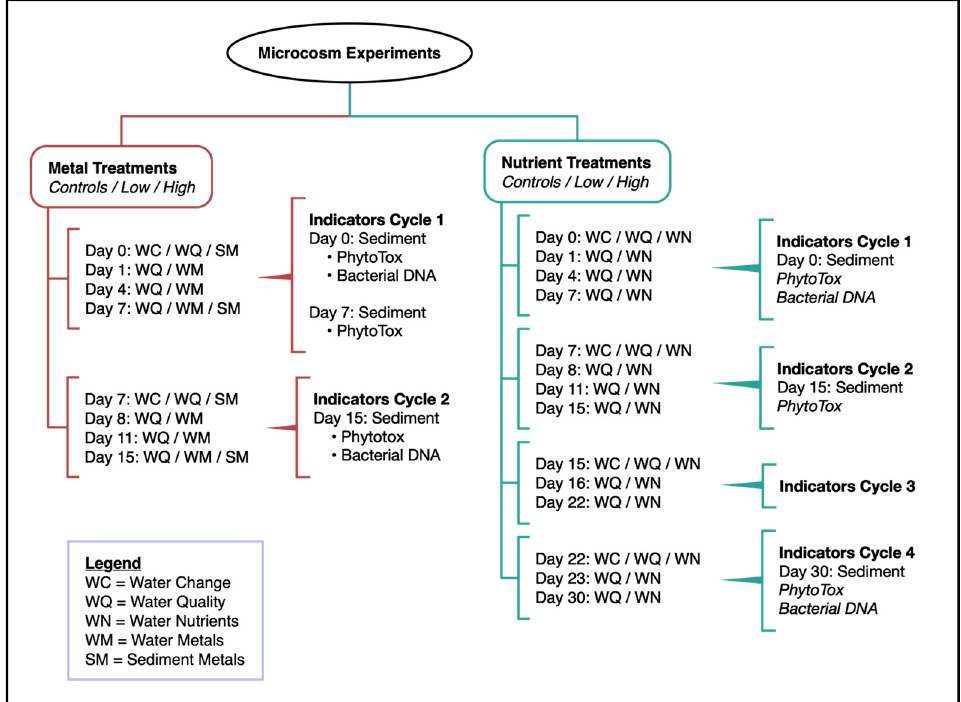
Figure 4. Experimental design for wetland sediment microcosm experiments that manipulated loadings of pollutant metals (metal treatments) and pollutant nutrients (nutrient treatments). Controls include sediment without pollutants. In test sediments, pollutants were added in two (low and high) concentrations. This same design was followed to build microcosms with sediments collected from wetland sites 1, 2, 3, and 4.